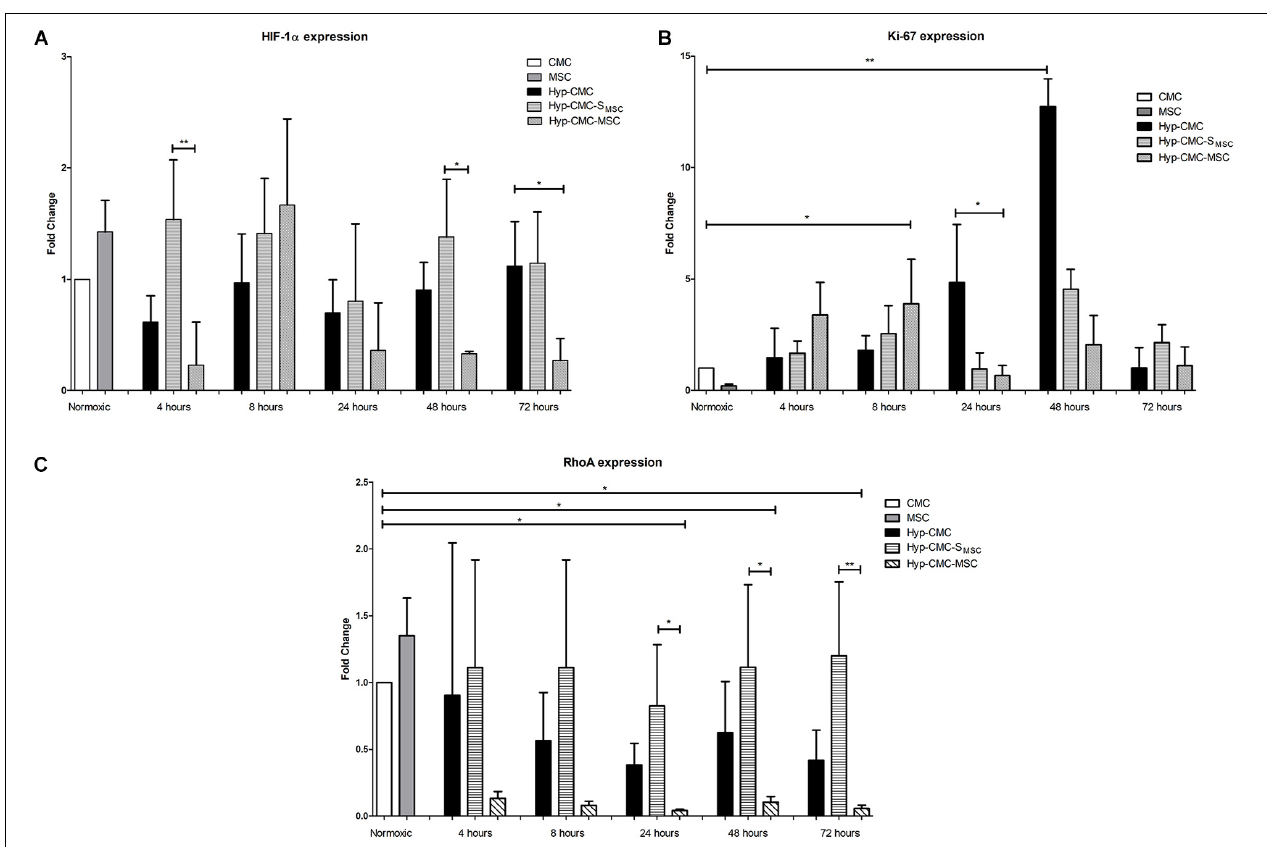
FIGURE 5 | Gene expression analysis of (A) HIF-1 α , (B) Ki-67 , and (C) Rho-A with RT-qPCR of the control CMC and MSC and of the samples taken from each of the three experimental groups: unstimulated hypoxic CMC (group Hyp-CMC), CMC stimulated with MSC secretome (group Hyp-CMC-S MSC ) and CMC stimulated directly with MSC (group Hyp-CMC-MSC) after the respective reoxygenation period of 4, 8, 24, 48, and 72 h. Values are relative to normoxic gene expression. HPRT was used as reference gene. The expression of each stimulation method was compared to the control group of the respective time point with one-way ANOVA (Kruskal-Wallis test) and groups were compared with the Dunn’s Multiple Comparison Test. * p < 0.05, ** p < 0.01, n = 4 technical replicates. MSC – Mesenchymal stem cells. CMC – cardiomyocytes. Hyp –